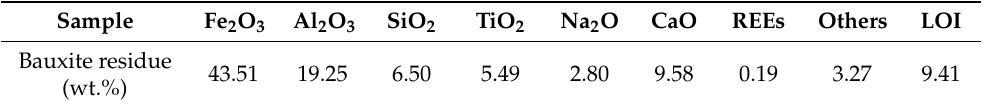
Table 1. Chemical analysis of bauxite residue.